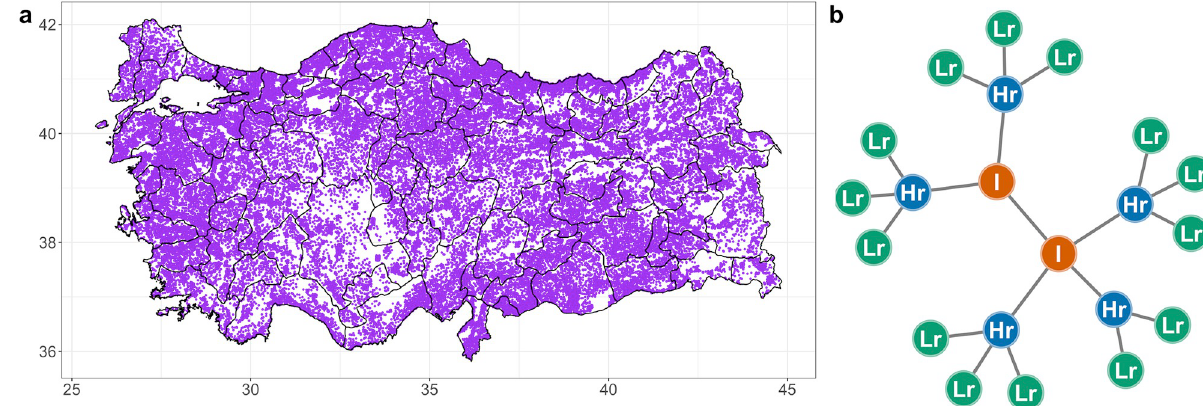
Fig 1. Location of epiunits in Turkey. Each purple dot represents the location of an epiunit in the map. b. Schematic representation for the definition infectious state of epiunits: Infected (red); high-risk (blue) and low-risk (green). Base layer of map available from https://gadm.org/download_country. html with license